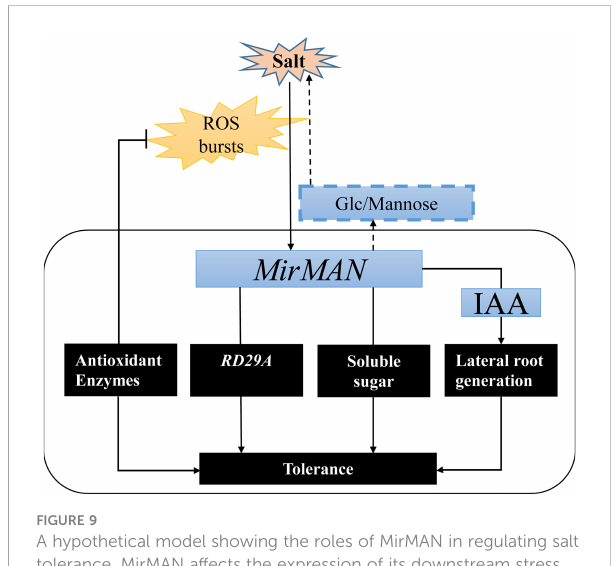
FIGURE 9 A hypothetical model showing the roles of MirMAN in regulating salt tolerance. MirMAN affects the expression of its downstream stress genes such as RD29A , mediating plant tolerance during development and salt stress. MirMAN can hydrolyze mannans and increase soluble sugar content to alleviate osmotic stress. It can also regulate plant tolerance by causing changes in the antioxidant enzyme